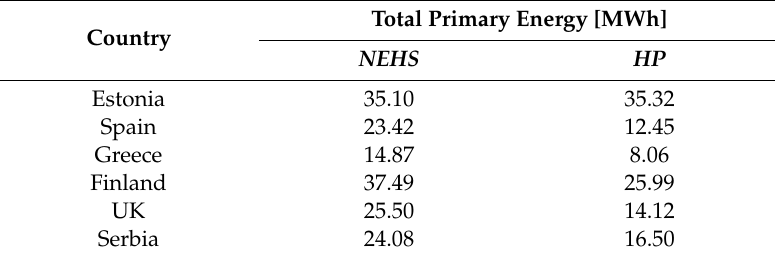
Table 7. Summary table for the total primary energy calculated per country and technology.